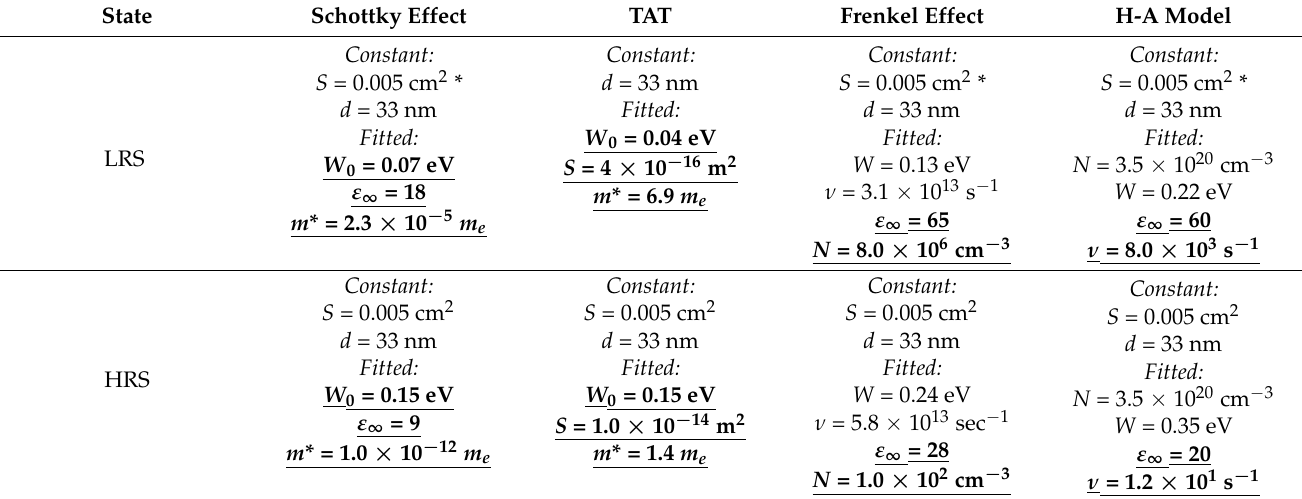
Table A1. Constant and fitted parameters of the Schottky effect, TAT model, Frenkel effect, and H-A model. The bold and underline parameters are parameters due to which the model does not fit experimental data.